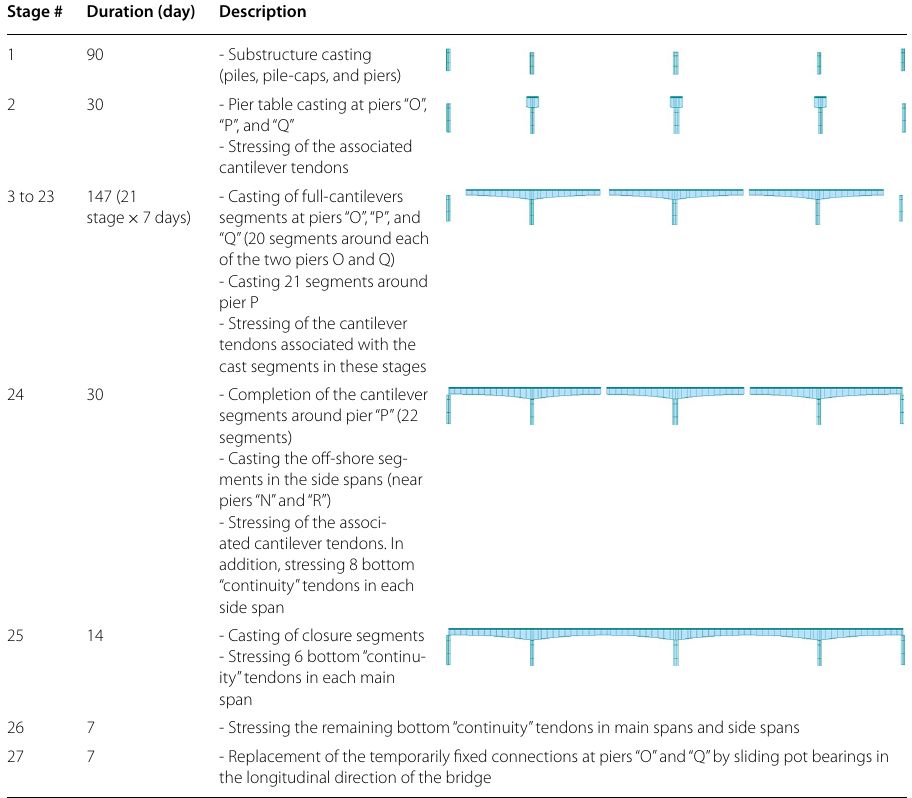
Table 1 Actual construction sequence of El-Warrak Bridge Stage # Duration (day)